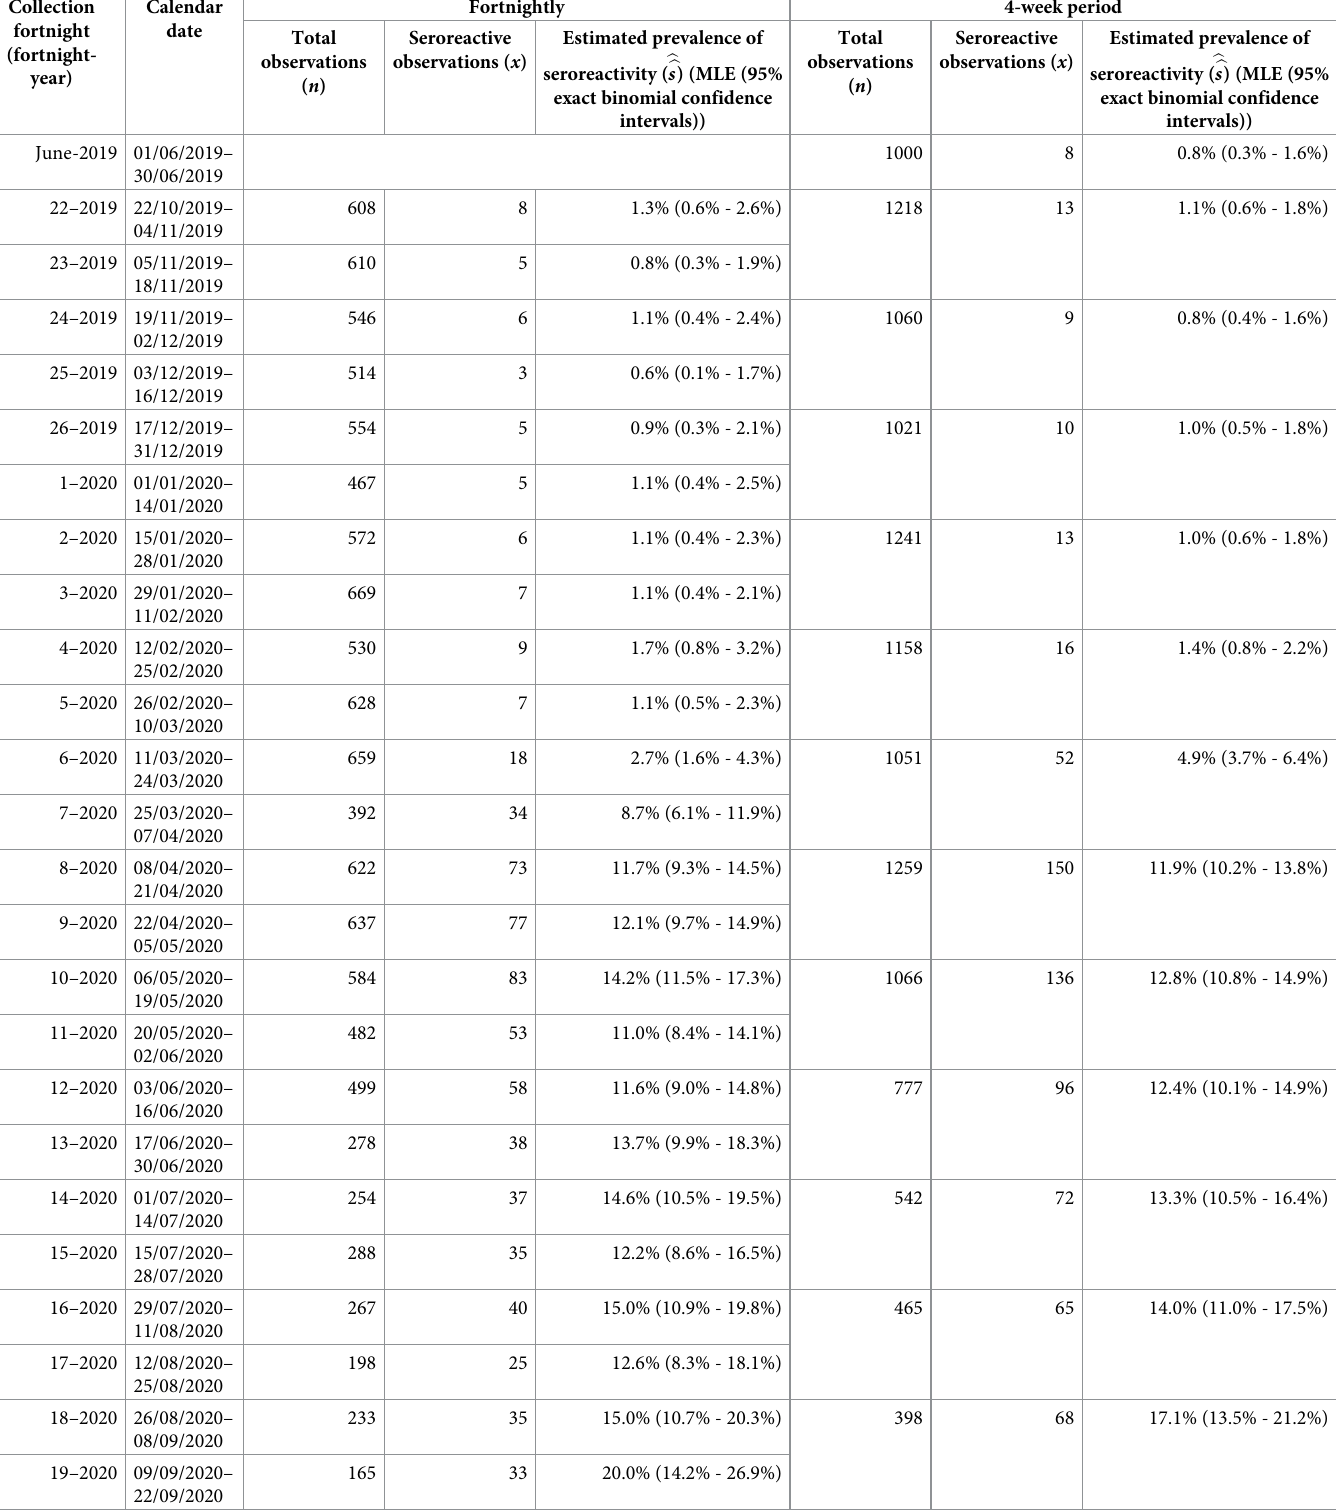
Table 2. Sample size and na ï ve prevalence of seroreactivity over time. The total number of observations and the number of seroreactive observations per fortnight and per four-week period using a seroreactive threshold of BR value � 1 in the primary study period (and per month in June 2019). This is used to calculate na ï ve estimates of the prevalence of seroreactivity with exact binomial 95% confidence intervals. Note fortnight 26 of 2019 spans across 15 rather than 14